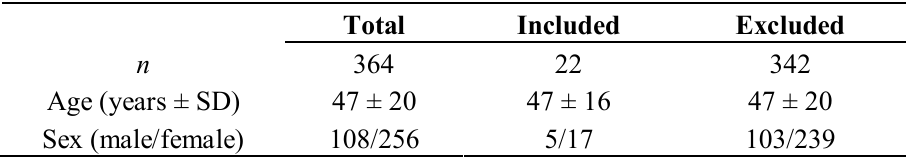
Table 1. Characteristics of screening